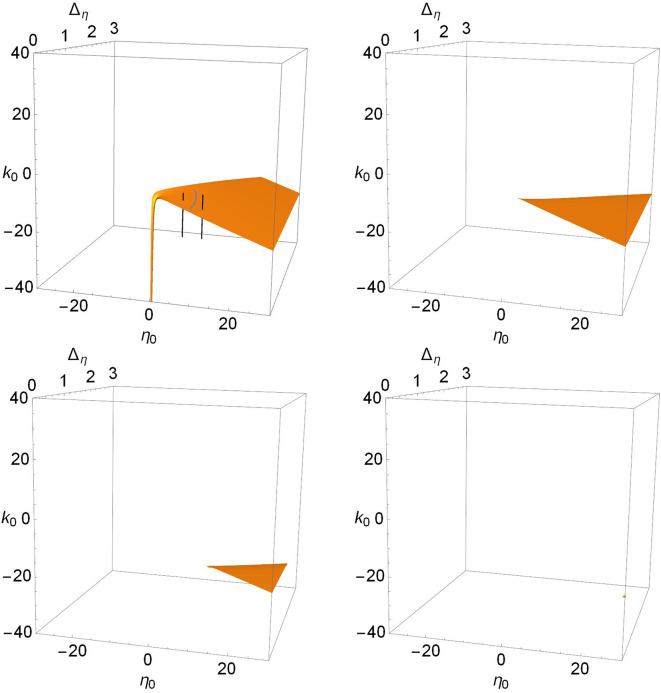
The Hopf surfaces disappear from view as Δk increases. n = 2 and Δk = 0.0 (top left), 1.0 (top right), 2.0 (lower left), and 3.0 (lower right). The gray line on the surface in the top left panel marks the boundary between sub- and super-critical Hopf bifurcations, and the black lines correspond to paths taken to create the one-dimensional bifurcation diagrams shown in Figure 8. Super-critical bifurcations occur on the side with larger η0, and in all the other panels.